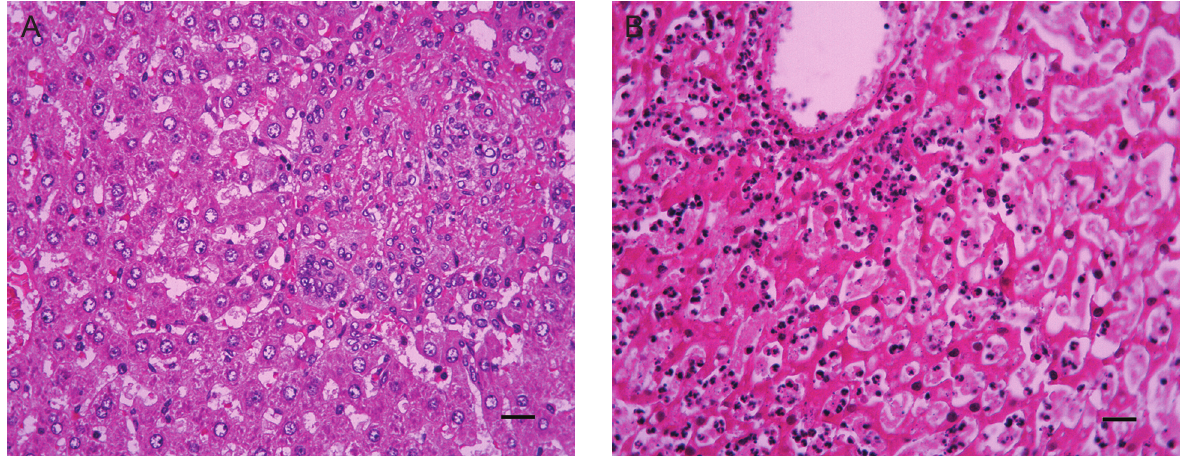
Figure 5. Liver specimen from the cerulein + L-NAME-treated group. A , Hepatocyte necrosis and sinusoidal dilatation are visible. H-E, 40X (bar = 20 µm). B , Diffuse hepatocellular degeneration, sinusoidal congestion and inflammatory infiltration are shown. H-E, 40X (bar = 20